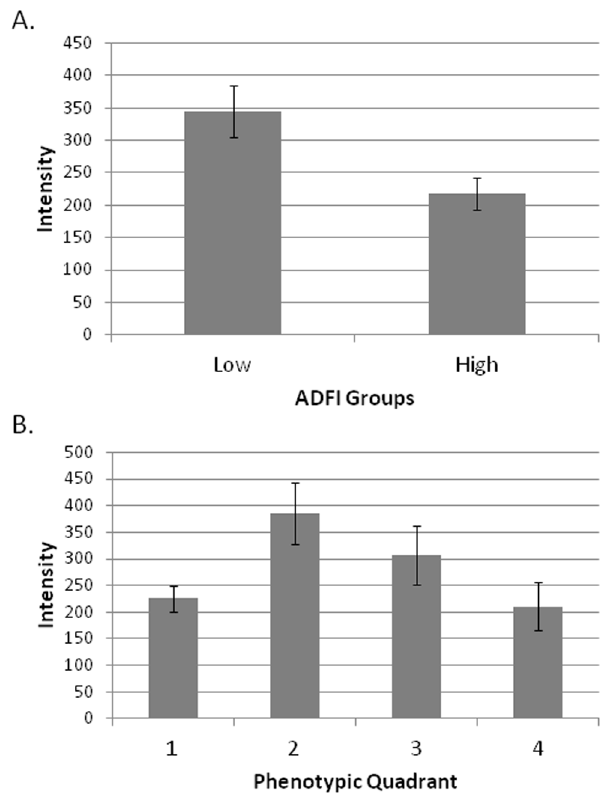
Figure 1. LCORL protein levels in steer muscle tissue measured by Western blot. A. LCORL protein levels by high and low ADFI groups. B. LCORL protein levels by ADFI and ADG phenotypic quadrants. Quadrant 1: high ADFI/high ADG, quadrant 2: low ADFI/ high ADG, quadrant 3: low ADFI/low ADG, and quadrant 4: high ADFI/ low